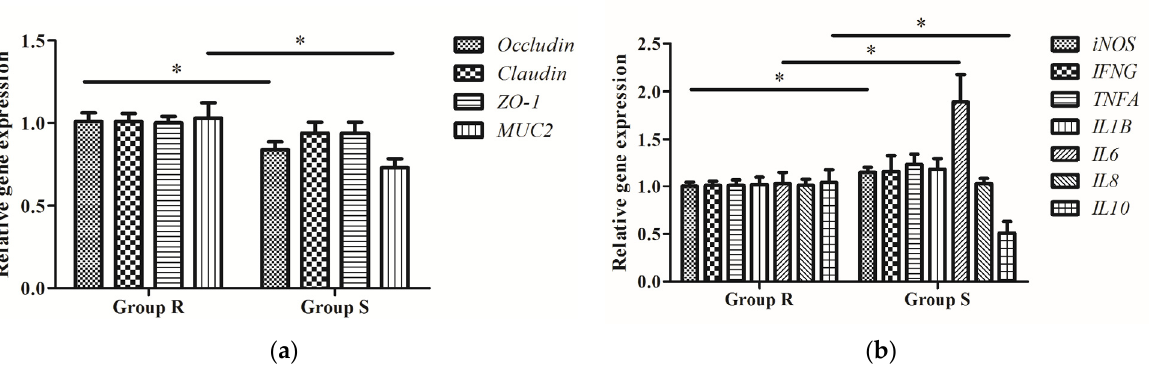
Figure 2. Relative expression of genes coding for tight junction proteins in the jejunum and inflammatory cytokines in cecal